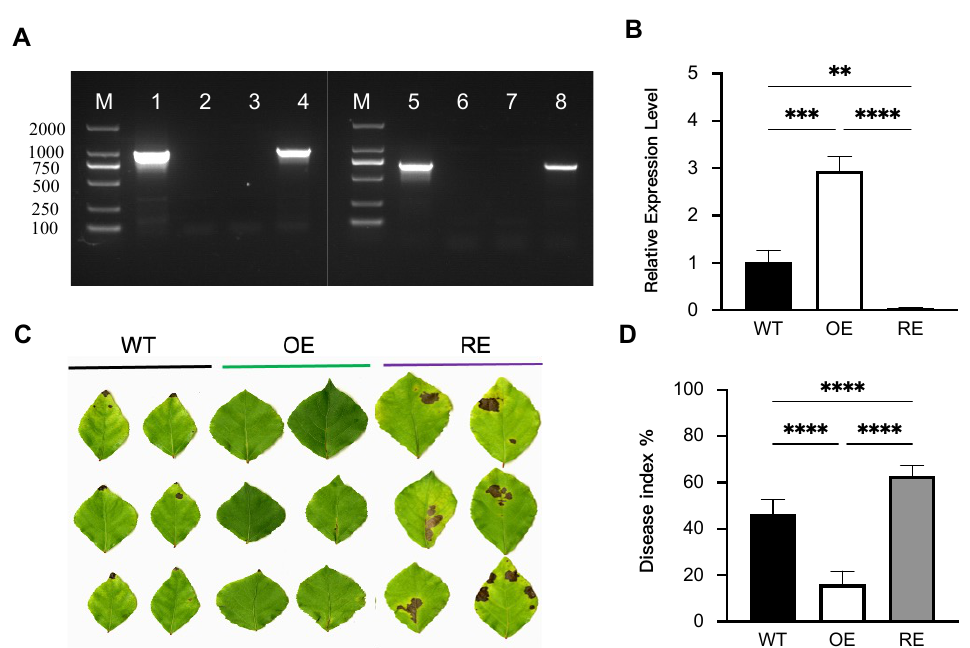
Figure 1. Molecular detection and disease severity of PsnWRKY70 transgenic lines infected with A. alternata . ( A ) PCR amplification of PsnWRKY70 transgenic lines, DNA ladder DL2000 (lane M), positive control (pGWB5- PsnWRKY70 -GFP plasmid) (lane 1), water control (lane 2), WT (lane 3), PsnWRKY70 OE lines (lane 4), positive control (pGWB5-amiRNAi PsnWRKY70 -GFP plasmid) (lane 5), water control (lane 6), WT (lane 7), and PsnWRKY70 RE lines (lane 8). ( B ) qRT-PCR detection of PsnWRKY70 transgenic lines ( n = 3, ** p < 0.01, *** p < 0.001, **** p < 0.0001). ( C ) Phenotype characterization of each transgenic line with inoculation of A. alternaria for 15 days. ( D ) Disease